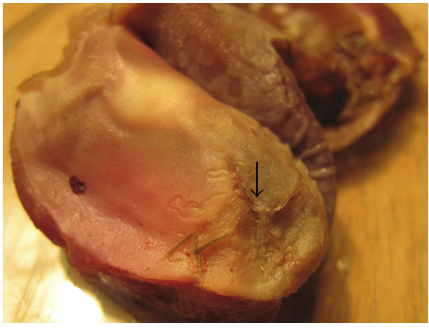
Figure 1: Cheilospirura hamulosa under the gizzard